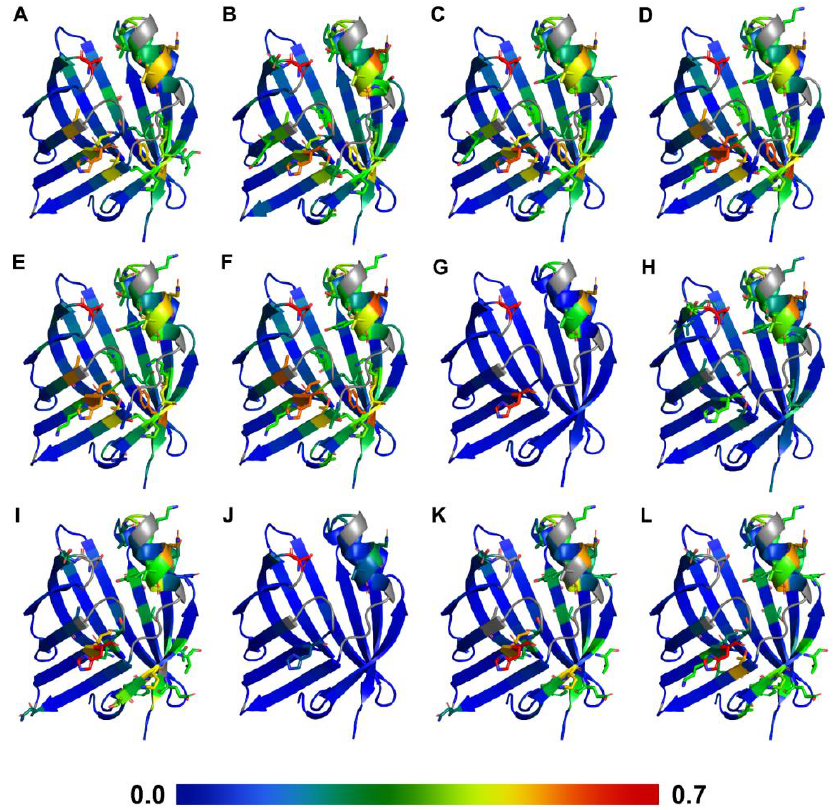
Figure 5. Mapping of the chemical shift perturbations (CSPs) caused by binding of ( A ) C8:0, ( B ) C12:0, ( C ) C14:0, ( D ) C16:0, ( E ) C18:1(n-9) c , ( F ) C20:5(n-3) c , ( G ) C8:0-carnitine, ( H ) C12:0-carnitine, ( I ) C14:0-carnitine, ( J ) C16:0-carnitine, ( K ) C18:1(n-9) c -carnitine, or ( L ) C20:5(n-3) c -carnitine onto the heart-type fatty acid-binding protein (FABP3) structure. The CSPs are color-coded, in which red indicates larger shifts, while blue indicates no changes in the averaged δ H and δ N NMR chemical shifts. Unassigned or disappeared residues are colored in gray. FABP3 structure is taken from PDB ID 3WVM.